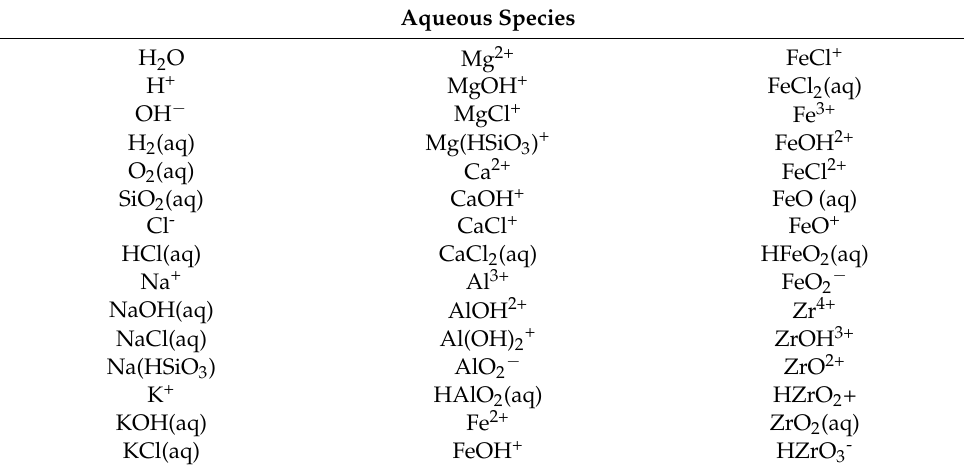
Table 2. Aqueous species included in the modelling.